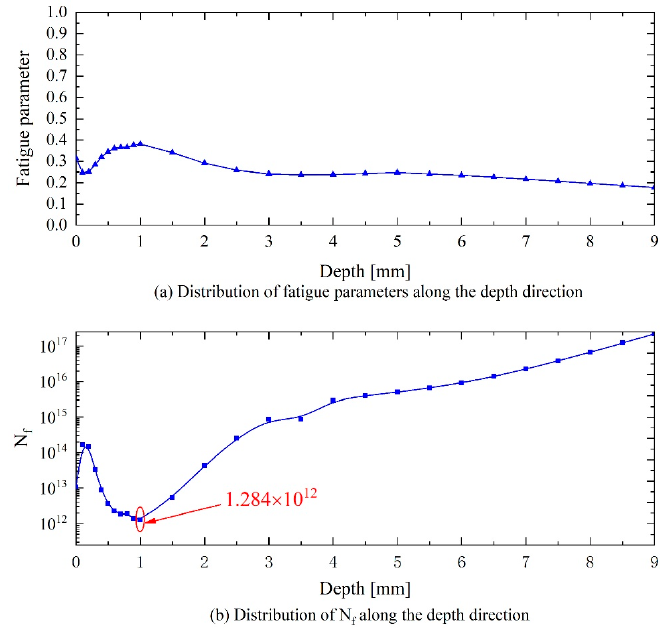
Figure 11. Fatigue parameters and life distribution, ( a ) distribution of fatigue parameters along the depth direction, ( b ) distribution of N f along the depth direction.